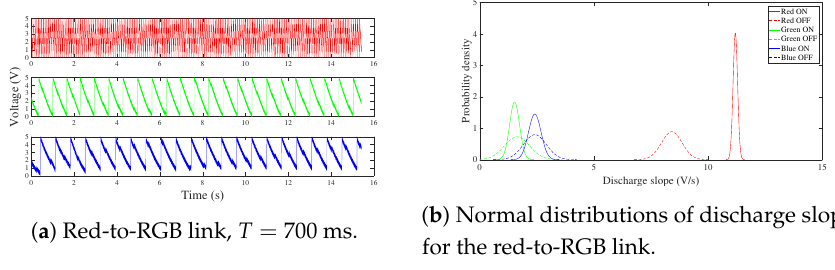
Figure 14. Red LED to RGB LED, T = 700 ms: transmitting with a red LED and sampling the three RGB colors.